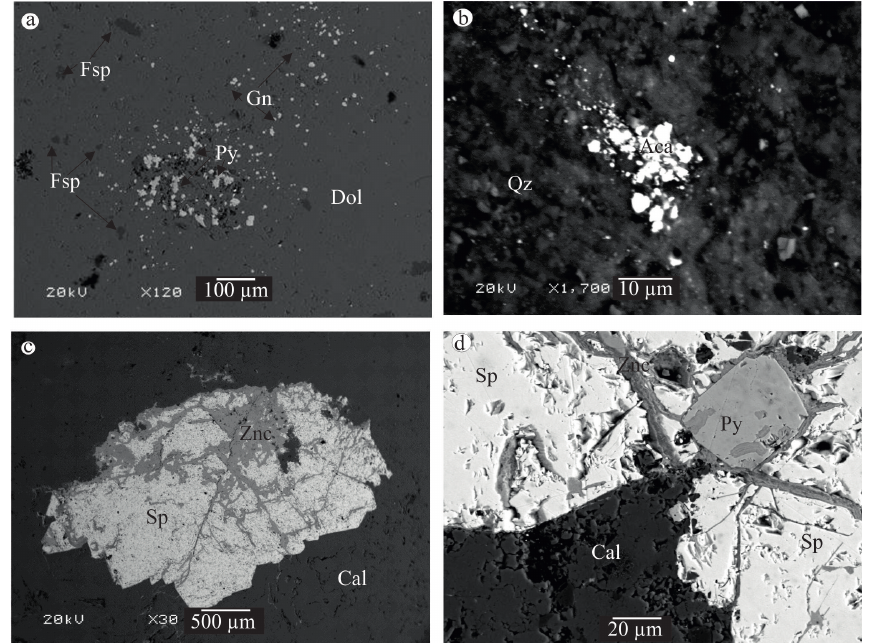
Figure 15. Sulfide minerals of hydrothermal-metasomatic formations (BSE mode): ( a ) inclusions of galena and pyrite in quartz-potassium feldspar dolomite; ( b ) aggregate structure of acanthite in quartz metasomatite; ( c ) large sphalerite developed in calcite veinlet, replaced by zincite along cracks and periphery; ( d ) inclusions of pyrite in sphalerite with thin veinlets of zincite. Qz—quartz; Fsp—potassium feldspar; Dol—dolomite; Py—pyrite; Gn—galena; Sp—sphalerite; Aca—acanthite; Cal—calcite; Znc—zincite.